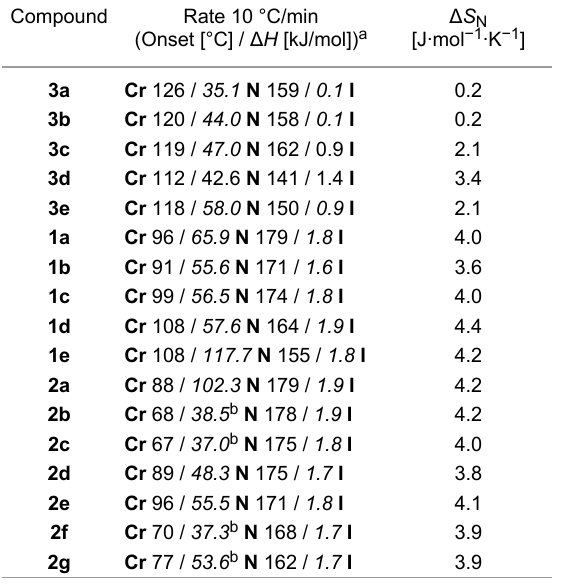
Table 1: Thermotropic behaviour of hockey stick compounds 3 and V-shaped molecules 1 and 2 . Compound